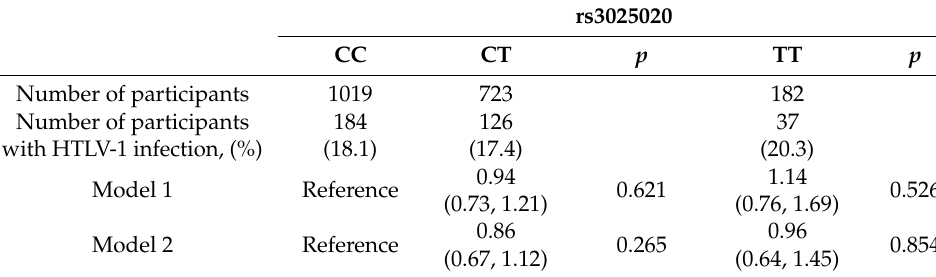
Table 4. Association between rs3025020 genotype and